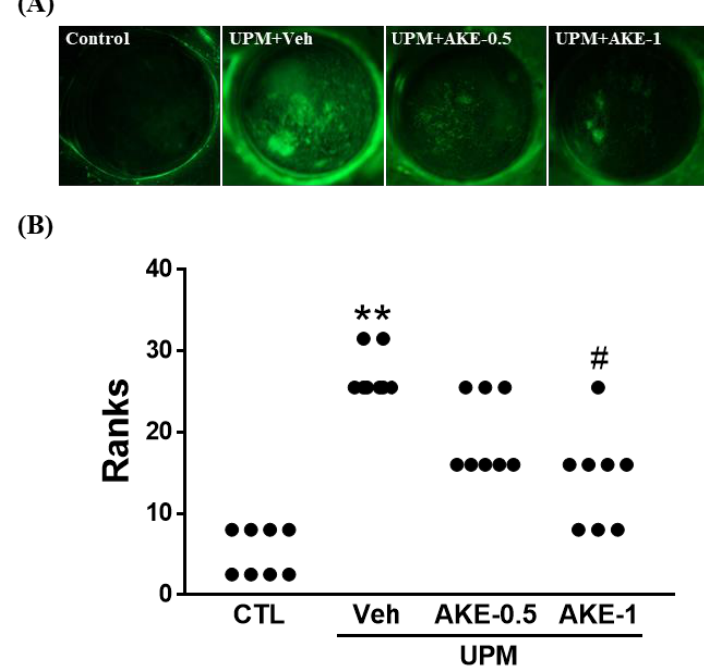
Figure 2. Effects of AKE on corneal epithelial damage in the UPM exposure-induced KCS model. ( A ) Representative images of corneal fluorescein. ( B ) Quantitative analysis of the corneal fluorescein staining score. Control group: CTL; vehicle group: Veh; 0.5 mg/mL AKE-treated group: AKE-0.5; and 1 mg/mL AKE-treated group: AKE-1. Data were presented as a median score using a ranks analysis (n ≥ 8). ** p < 0.01 vs. CTL, # p < 0.05 vs. Veh.